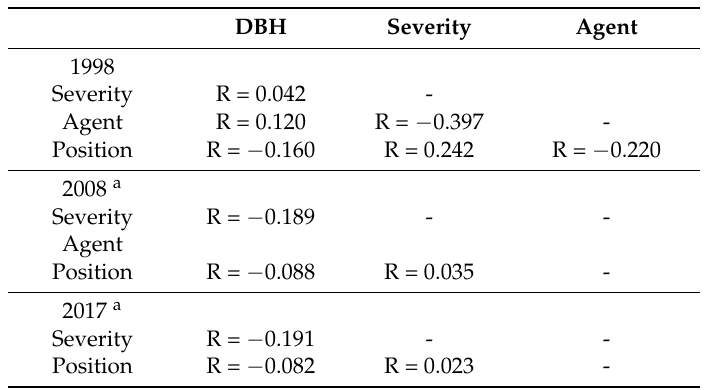
Table 6. Correlation matrix among diameter at breast height, damage severity, agent, and position (Spearmann R, p < 0.05 in bold) after thinning in 1998 (N. = 135), 2008 (N. = 138) and 2017 (N. = 140). Severity, agent, and position were ranked as in Tables 3–5.